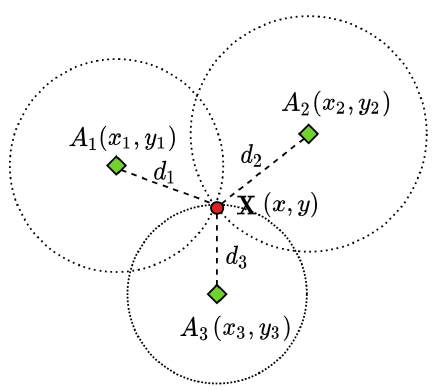
Figure 3. Two-dimensional trilateration problem of determining an object (red solid circle) location X given the location of three stations (green diamonds) A i and the range measurements/distances d i ( i =